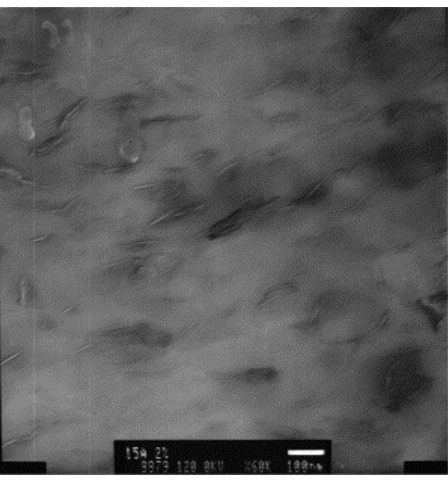
Figure 7. TEM image of precipitated 2 wt % Cloisite ® 15A/PVDF after hot-pressing into a film. The exfoliated silicate layers appear as sharp lines on a grey background from the PVDF matrix (Reprinted with permission from [81]. Copyright 2006